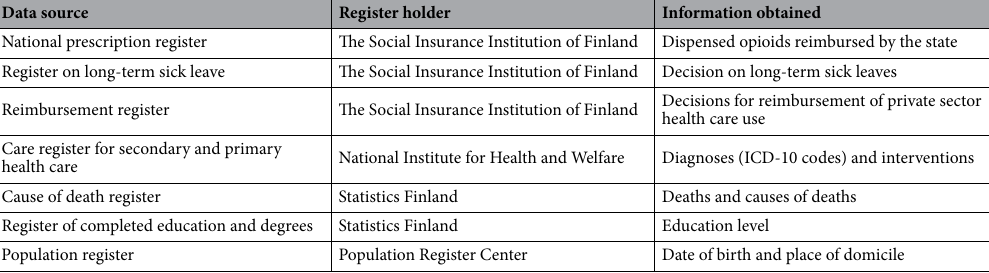
Table 1. Data sources and information